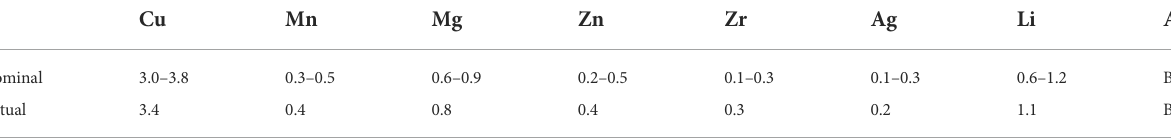
TABLE 1 The nominal and actual concentrations of chemical elements in 2060 alloy (in weight